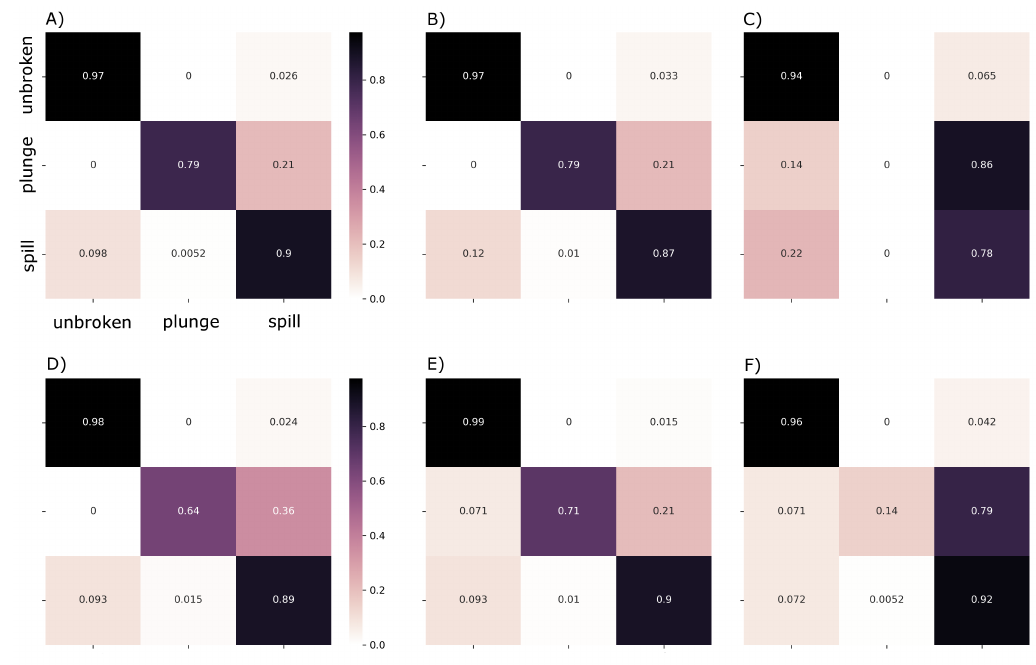
Figure 3. Confusion matrices for models training without image augmentation: ( A ) MobilenetV2; ( B ) Xception; ( C ) Resnet-50; ( D ) InceptionV3; ( E ) Inception-ResnetV2; ( F ) VGG19. For each confusion matrix, the abscissa represents estimated and the ordinate represents true.